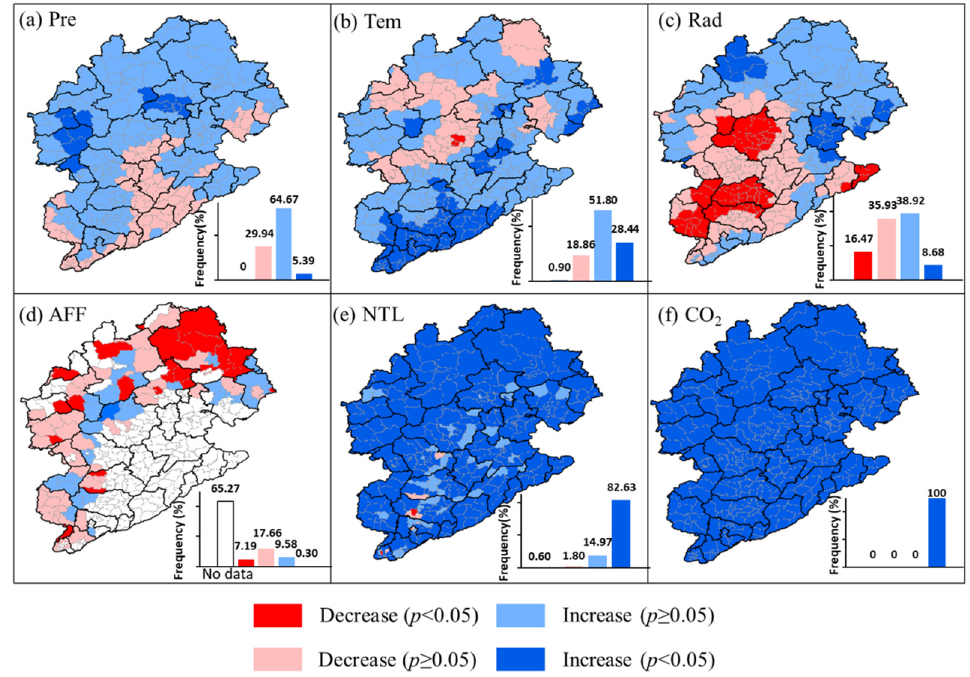
Figure 4. Interannual linear trends of ( a ) precipitation rate, Pre; ( b ) 2-m air temperature, Tem; ( c ) downward shortwave radiation, Rad; ( d ) area of afforestation (AAF); ( e ) nighttime light (NTL); and ( f ) CO 2 from 2002 to 2018. Significant trends indicate p -value < 0.05. The histogram in each panel shows the frequency of various trends, and the negative/positive values represent the decreased/increased trends. White color means no data in this county.